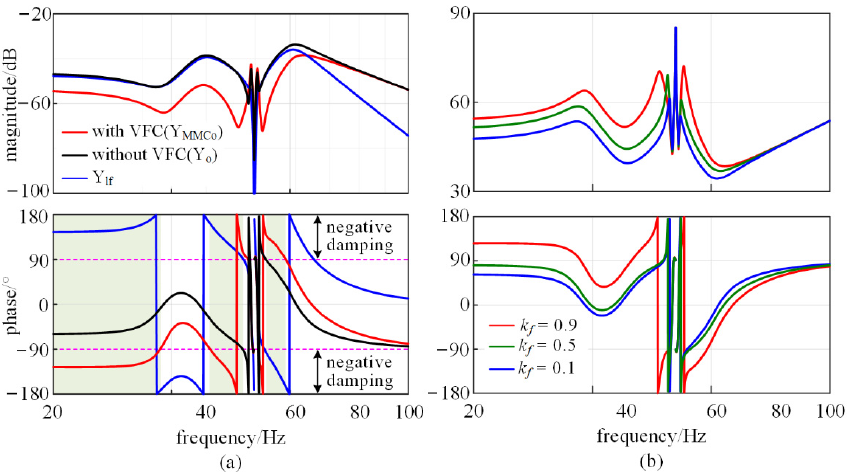
Figure 5. Impacts of voltage feedforward control on admittance characteristics of MMC-HVDC (VFC stands for voltage feedforward control). ( a ) comparison of MMC-HVDC impedance charac- teristic w/wo voltage feedforward control. ( b ) impacts of voltage feedforward control parameters on MMC-HVDC impedance